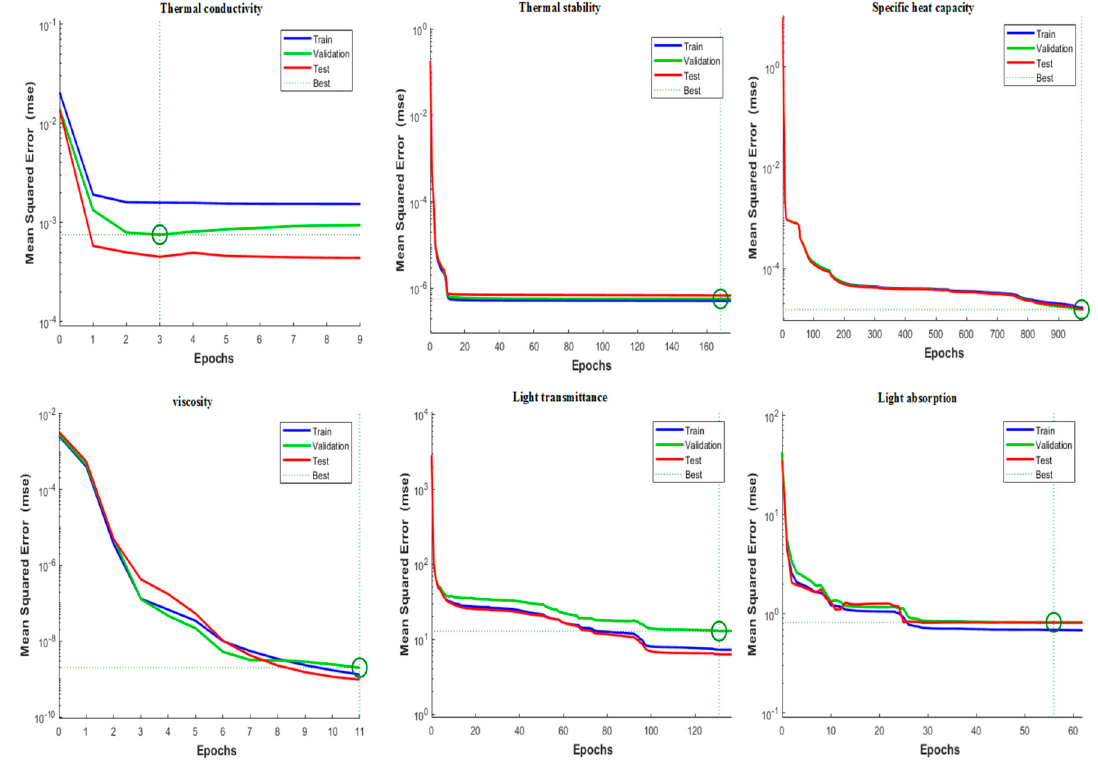
Figure 4. Performance summary plot.